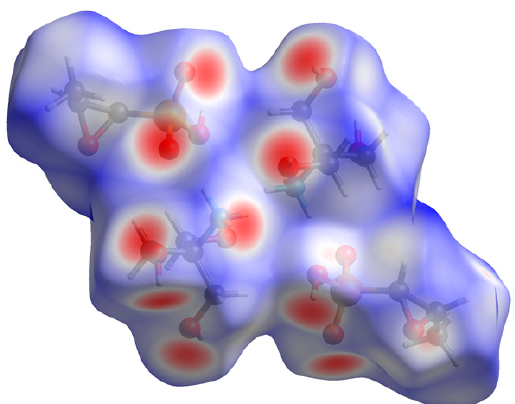
Figure 7. The Hirshfeld surface of fosfomycin tromethamine. The intermolecular contacts longer than the sums of the van der Waals radii are colored blue, and contacts shorter than the sums of the radii are colored red. The contacts equal to the sums of radii are white. Table 2. The hydrogen bonds (CRYSTAL14) in fosfomycin